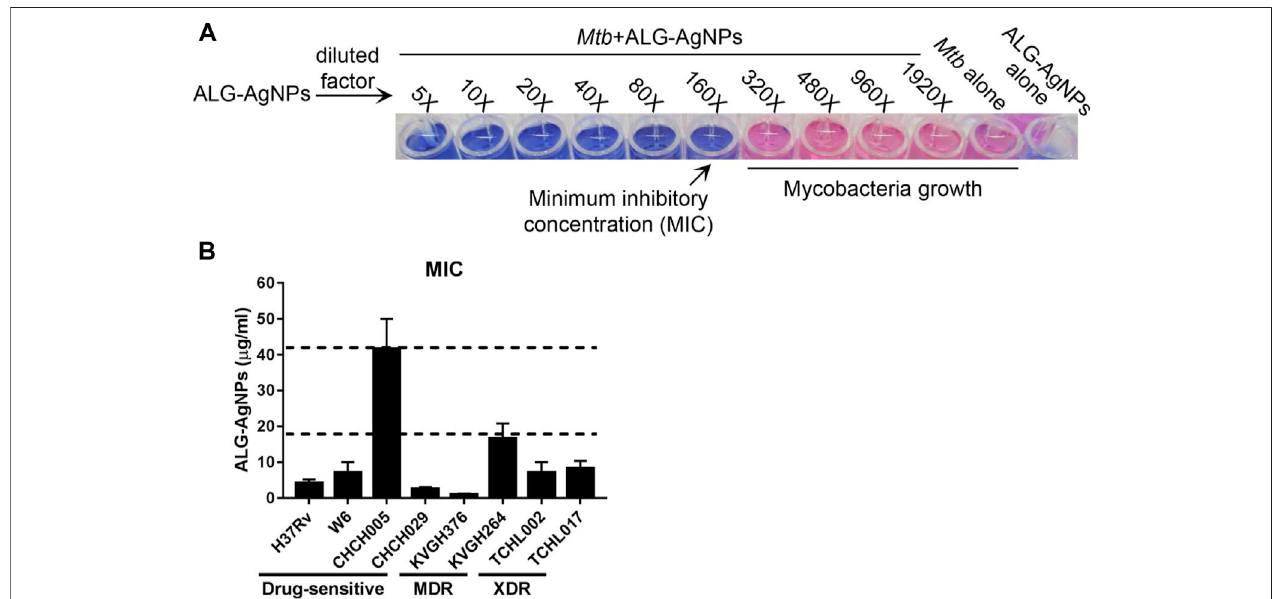
FIGURE 2 | ALG-AgNPs have potential anti-mycobacterium activity against various pathogenic strains of Mycobacterium tuberculosis in vitro . (A) Schematic diagramoftheAlamarblueassayemployed forMICdetermination. (B) MICsofALG-AgNPs determined fordifferentstrainsof Mtb .Thedatarepresentmean ± SEMof3 experiments. MIC: minimum inhibitory concentration; MDR: multidrug-resistant TB; XDR: extensively drug-resistant TB.